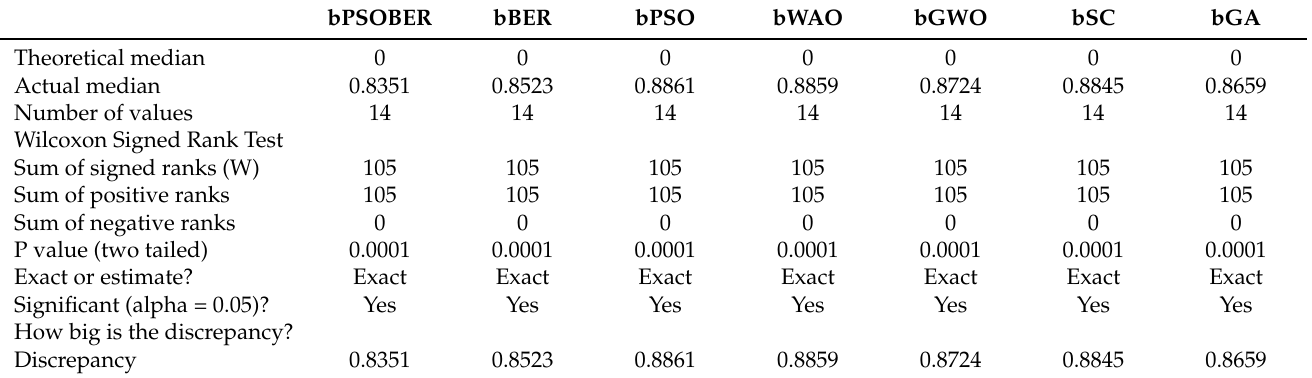
Table 7. The Wilcoxon signed-rank test for evaluating the the proposed feature selection algorithm (bPSOBER) compared to other competing feature selection methods.